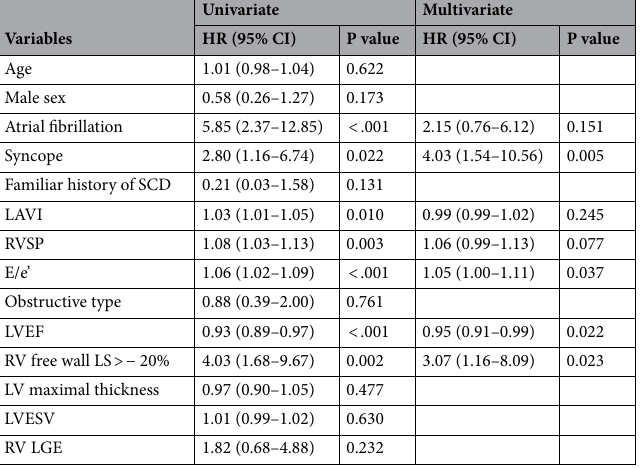
Table 4. Univariate and multivariate Cox proportional hazard model for primary outcomes in patients with strain echocardiography (n = 190). SCD sudden cardiac death, LAVI left atrial volume index, RVSP right ventricular systolic pressure, RV right ventricle, LV left ventricle, LVEF left ventricular ejection fraction, CMR cardiac magnetic resonance, LVESV left ventricular end systolic volume, LGE late gadolinium enhancement.